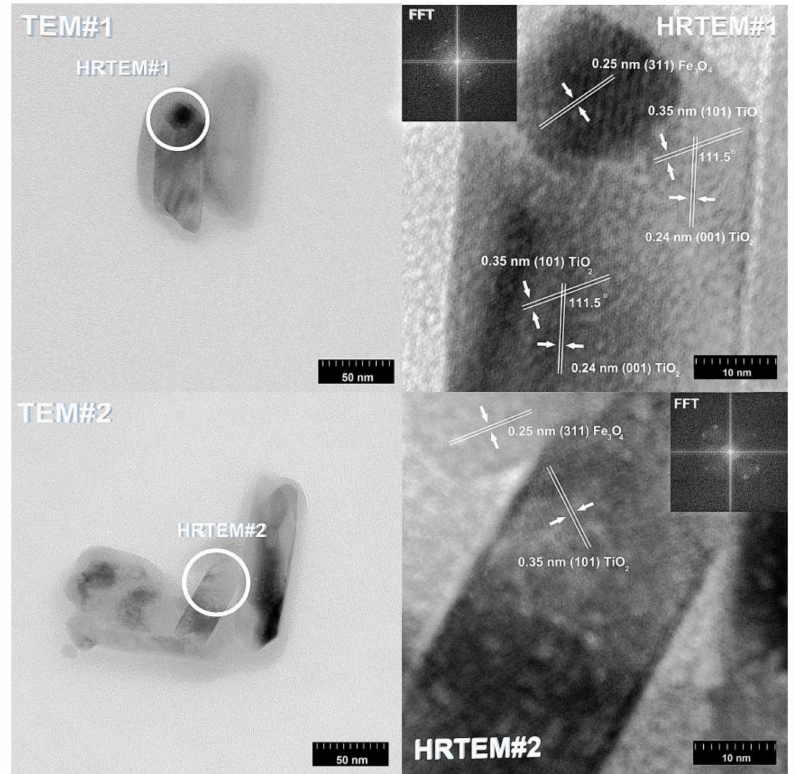
Figure 5. TEM, HR-TEM, and FFT results for the (3)TiO 2 -(7)Fe 3 O 4